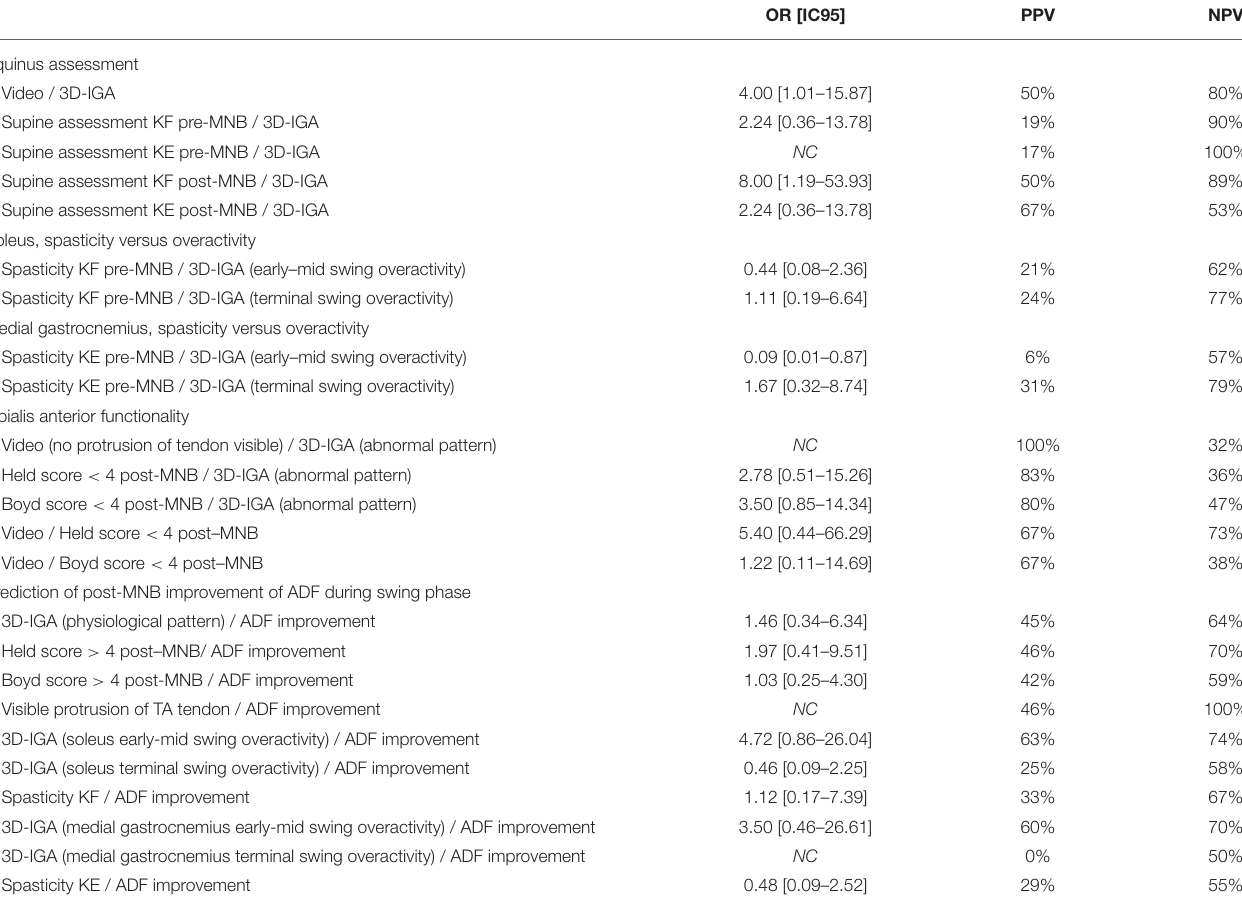
TABLE 3 | Associations between clinical, instrumental, and post-MNB data studied with odds ratios, positive, and negative predictive